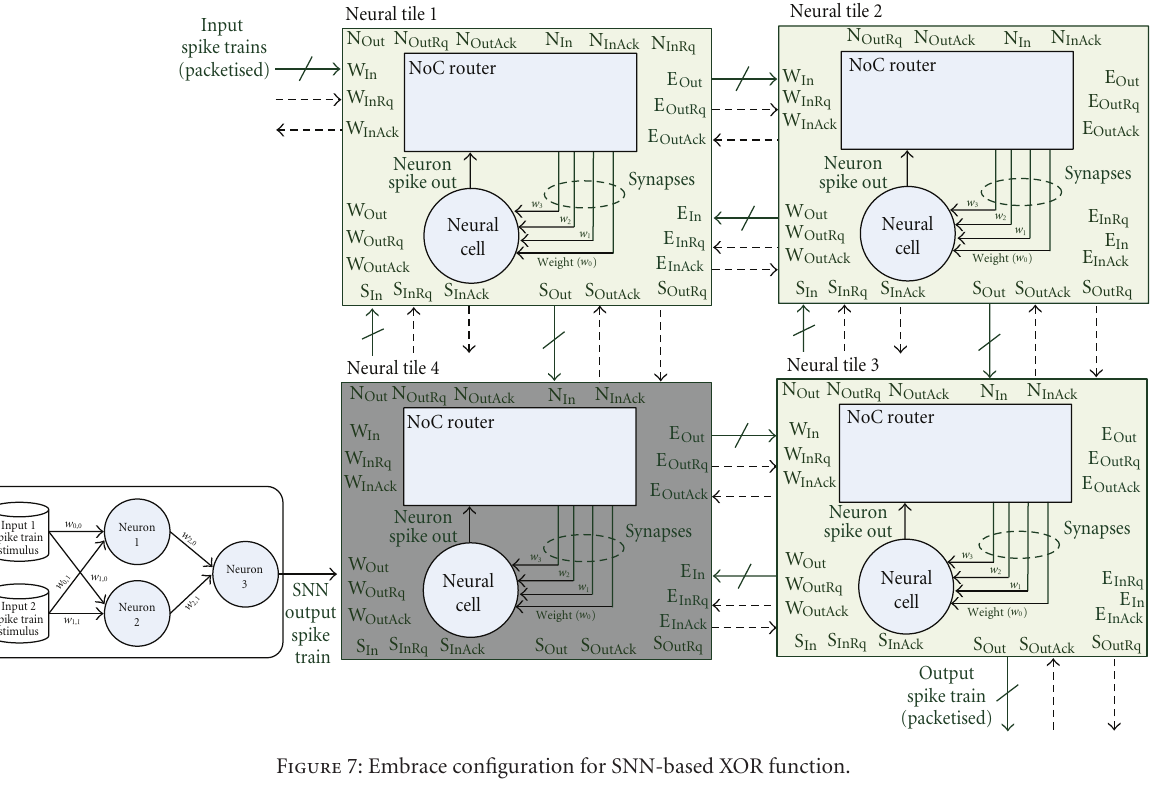
Figure 7: Embrace configuration for SNN-based XOR function.